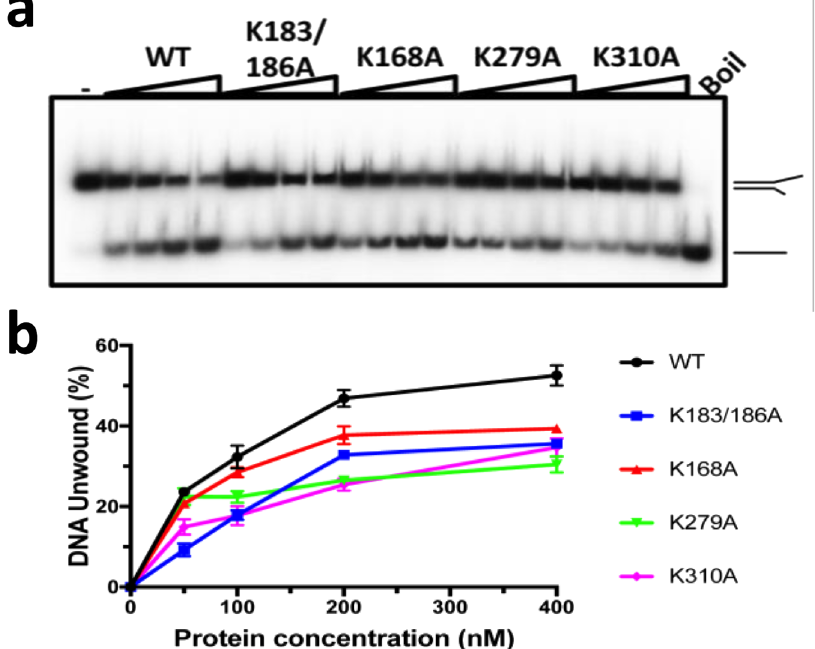
Fig. 4 Unwinding activity of E1 mutants. Mutations were generated to disrupt interactions with the dsDNA (double mutant K183A/K186A) and 5 ′ ssDNA (K168A and K279A in the OBD and K310A in the inter-domain linker) of E1. a Puri fi ed proteins (50, 100, 200 and 400 nM) were assayed using a fork-like substrate (0.1 nM) with the same sequence used to form E1RF. Boil is the thermally denatured substrate and ‘ - ’ is the native substrate (no E1). b Graphical representation of the data ( n = 3 independent experiments; shown mean values with error bars ± SD). Wild-type (Wt), black line; K183/K186A, blue; K168A, red; K279A, green; K310A,